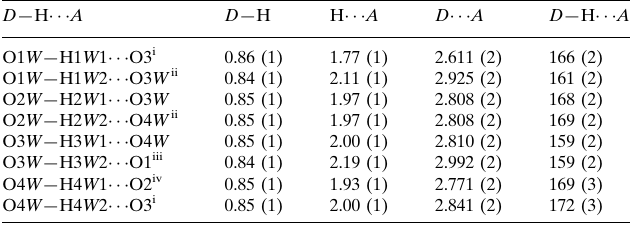
Hydrogen-bond geometry (A˚ , (cid:2)